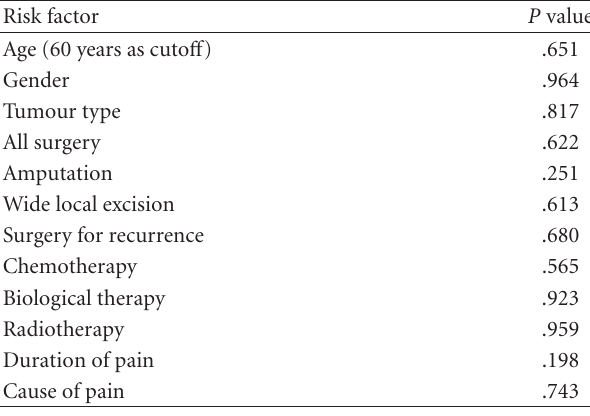
Table 5: Risk factors assessed for prediction of pain